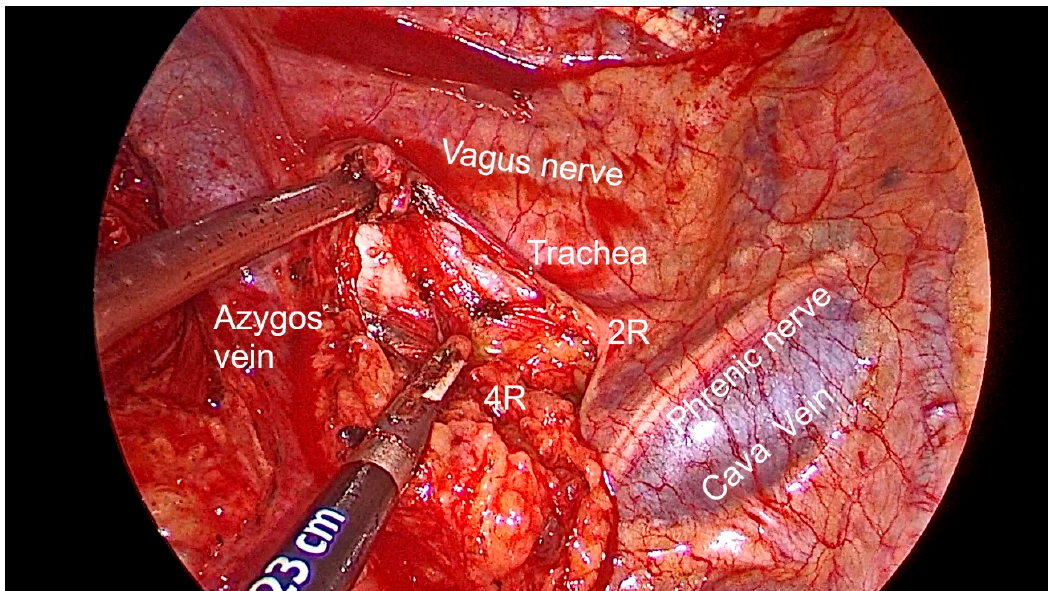
Figure 5. Anatomic landmarks during right paratracheal lymph node dissection (2R and 4R).